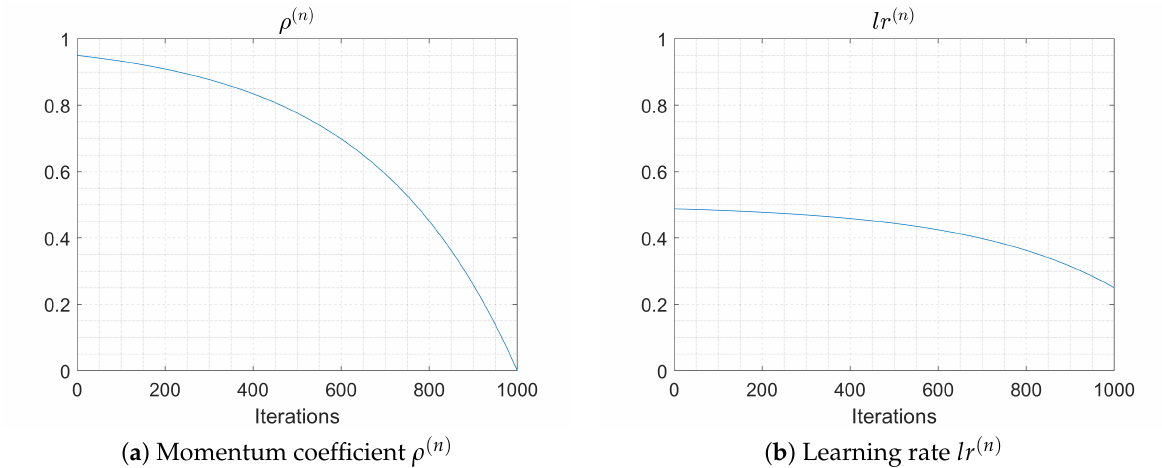
Figure 8. Critical parameters in the iterative procedure of